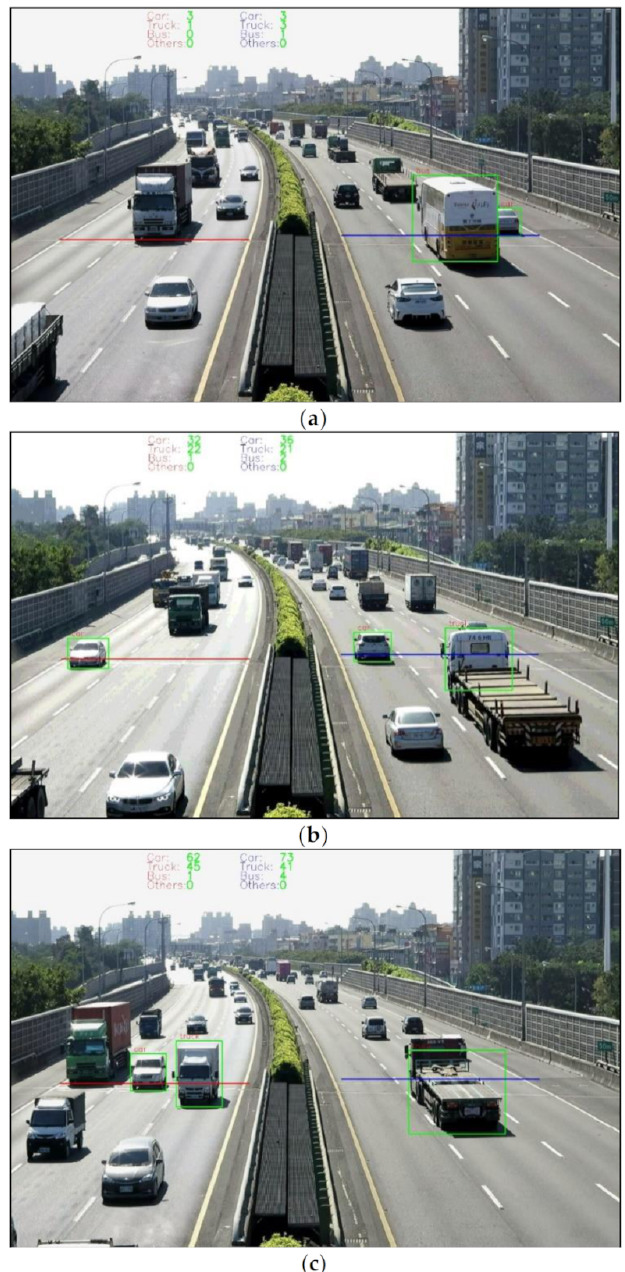
Figure 8. The results of vehicle counting in both the northbound and southbound lanes from the video taken on National Freeway No.1 ( a – c ). The red line represents the virtual line in the northbound direction, while the blue line represents the virtual line in the southbound direction. Note that only the vehicles approaching the virtual lines were tracked (marked with green